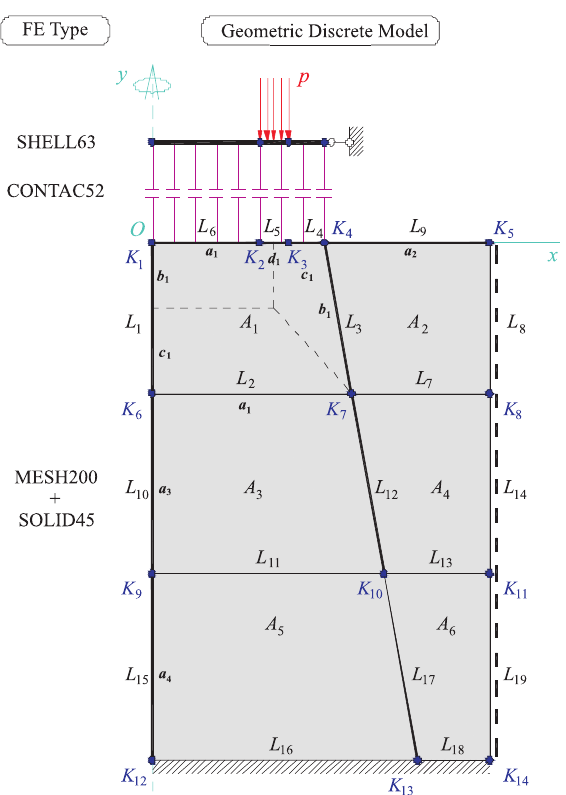
Fig. 5. The so-called “bottom up” modeling schema of circular plate on deformable foundation